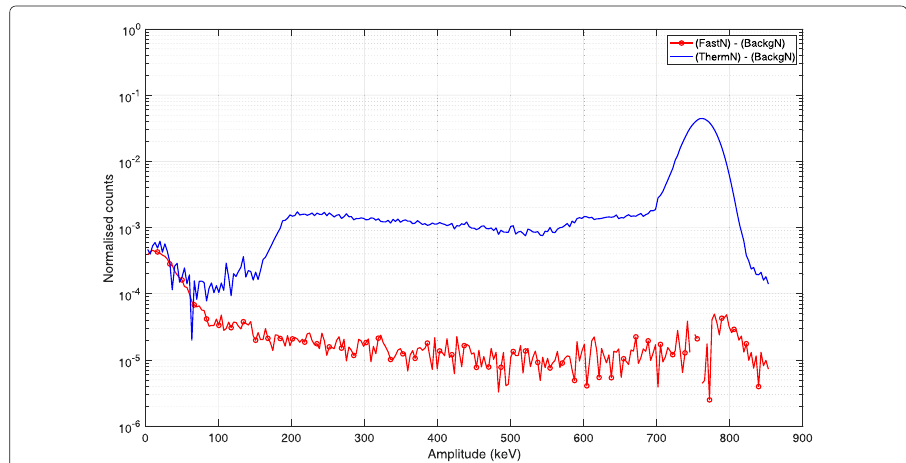
Fig. 12 PHS of thermal neutrons (blue) and fast neutrons (red). The (BackgN) measurement has been subtracted in the case of (FastN), in order to ensure that the spectrum refers to fast neutron events